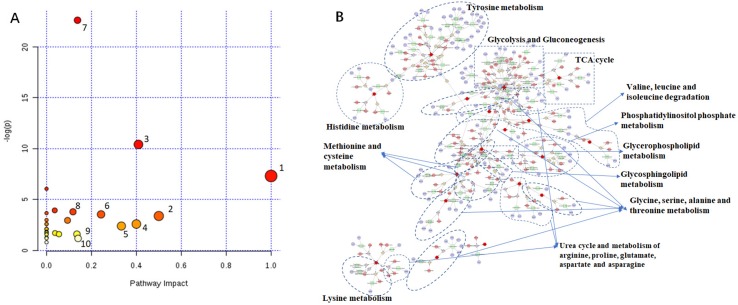
Metabolic Pathway Analysis of TSC-treated rats. (A) 1. Aminoacyl-tRNA biosynthesis, 2. Alanine, aspartate and glutamate metabolism, 3. D-Glutamine and D-glutamate metabolism, 4. Cysteine and methionine metabolism, 5. Glycine, serine and threonine metabolism, 6. Phenylalanine, tyrosine and tryptophan biosynthesis, 7. Methane metabolism, 8. Valine, leucine and isoleucine biosynthesis, 9. Inositol phosphate metabolism, 10. Tyrosine metabolism. (B) Red hexagon: metabolites; green round rectangle: enzyme; blue elipse: protein; gray diamond: reaction.